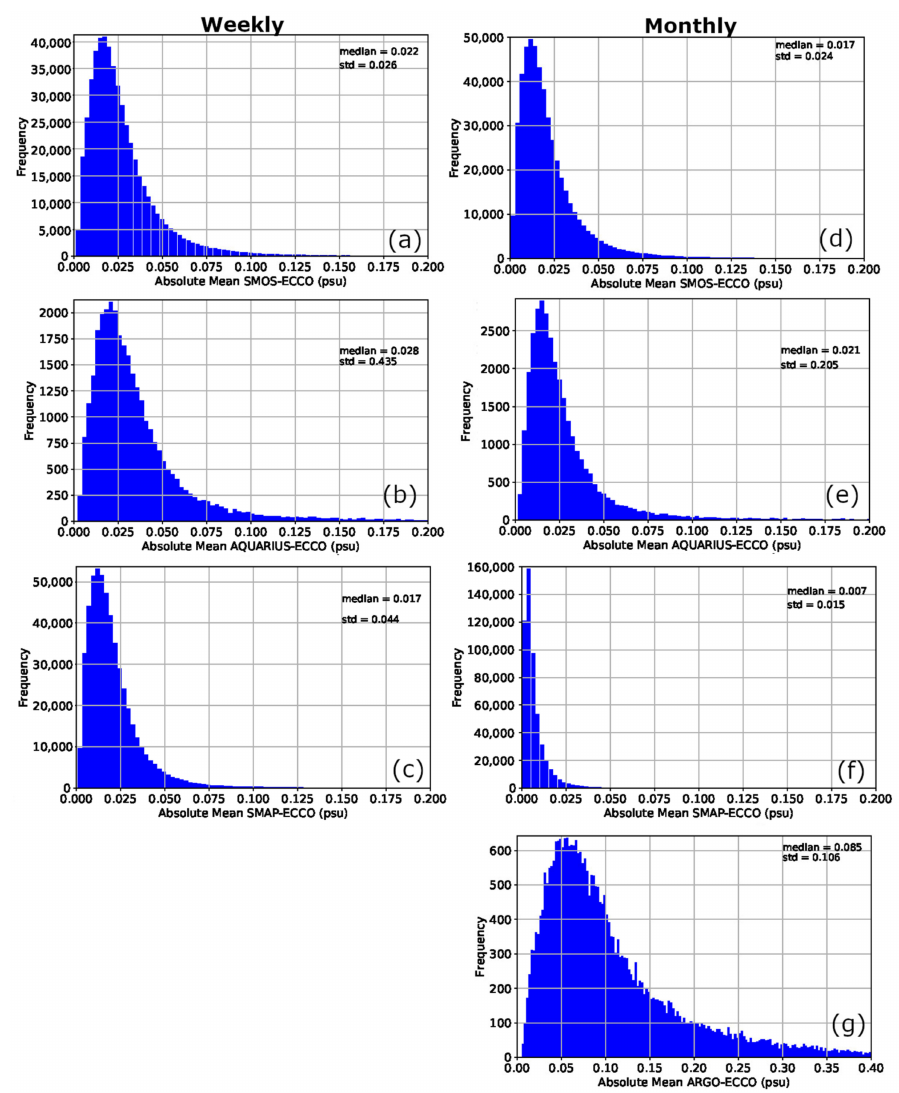
Figure 5. Histograms of the sampling error, i.e., the global absolute differences between our weekly ground truth (ECCO model) and ( a ) SMOS (9 days), ( b ) Aquarius (7 days), and ( c ) SMAP (8 days) SSS and between our monthly ground truth (ECCO model) and ( d ) SMOS, ( e ) Aquarius, ( f ) SMAP, and ( g ) ARGO. Note different x-axis limits for panel ( g ). Median (the global sampling error) and standard deviation of the sampling error is given in the upper right-hand corner of each